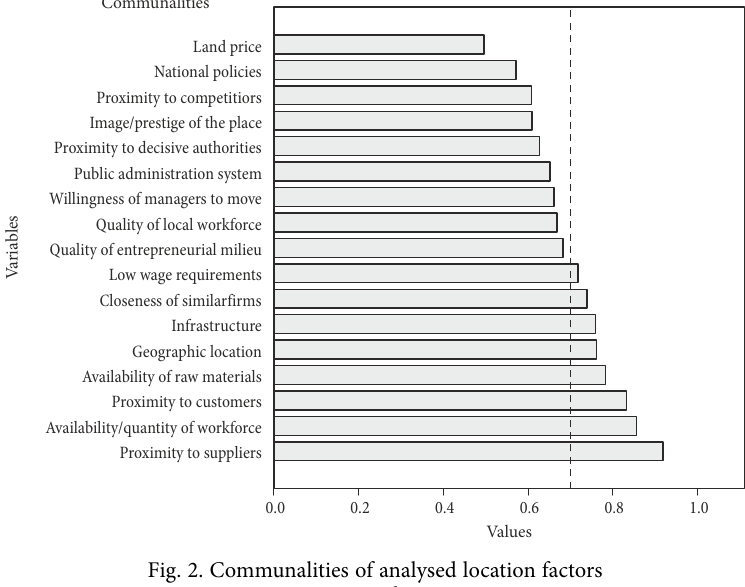
Fig. 2. Communalities of analysed location factors Note: authors.